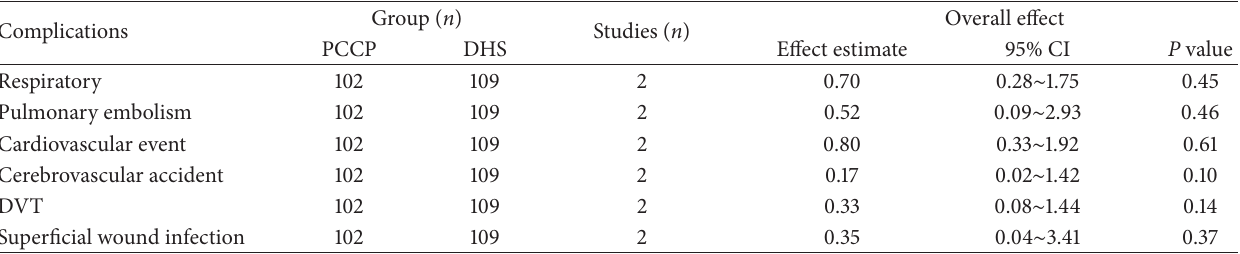
Table 2: Meta-analysis results of complications comparing PCCP with